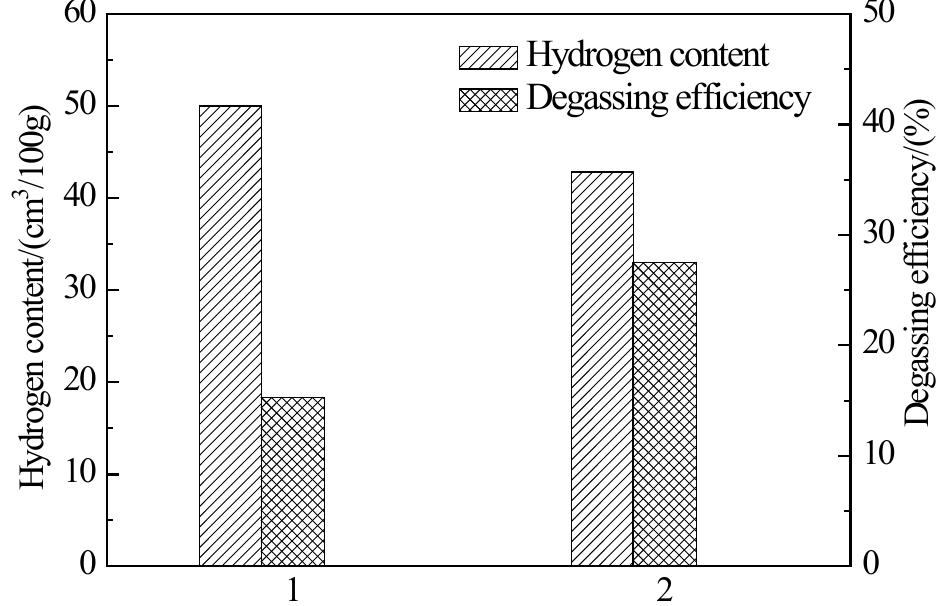
Figure 5. Effect of ultrasonic resonance and non-resonance on the degassing efficiency of Mg-3.03Ca alloy. 1—Non-resonance 2—Resonance.